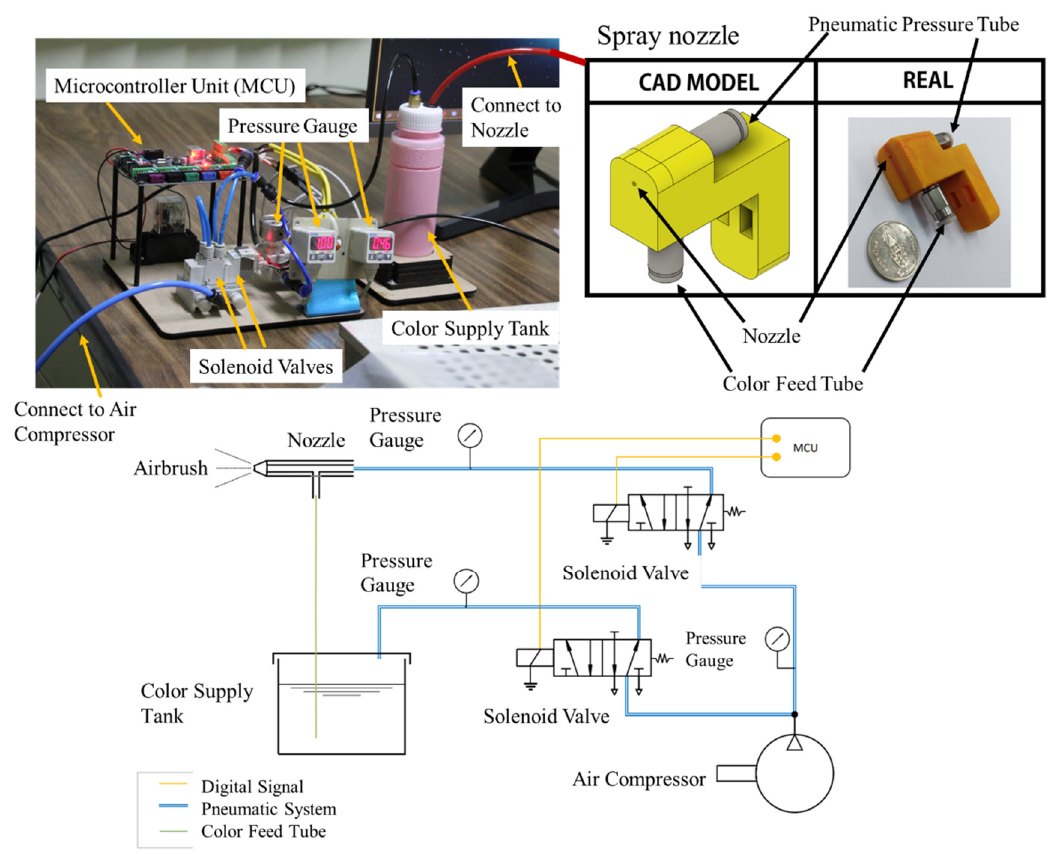
Figure 6. Spray Gun System and Architecture.